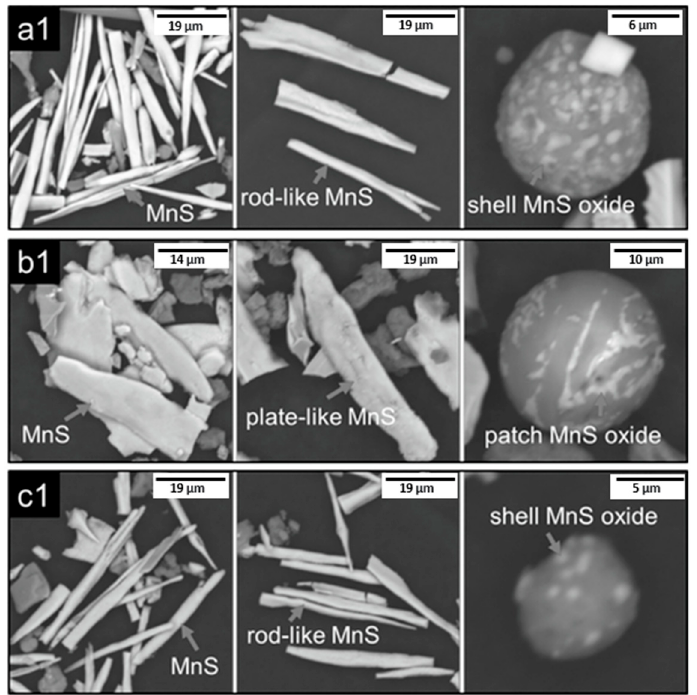
Figure 7. 3D morphology of typical MnS inclusions in rail extracted using non-aqueous electrolyte; ( a1 ), ( b1 ) and ( c1 ) represent the rail head, rail waist and rail bottom, respectively [18]. The length scales have been updated in the current paper. Copyright 2016 WILEY-VCH Verlag GmbH & Co. KGaA, Weinheim.